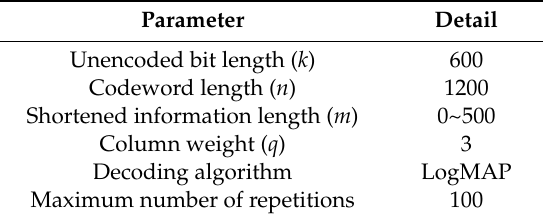
Table 3. Parameters of shortened RA code.